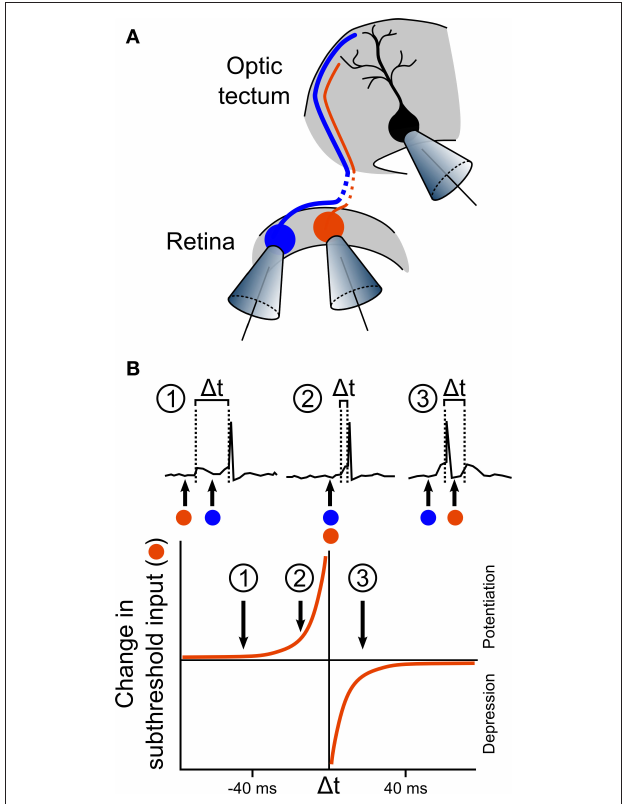
Figure 2 | First in vivo observation of STDP in the optic tectum. (A) The first in vivo demonstration of STDP was performed by Zhang et al. (1998) in an elegant experiment, illustrated here. Activity from a single tectal neuron was recorded using whole-cell perforated patch, while two different RGCs that form synaptic connections onto the tectal neuron were loose-patched, allowing stimulation for induction of LTP or LTD. In some of the recordings, one RGC produced suprathreshold responses (illustrated by the blue cell), whilst the other produced only subthreshold responses (illustrated by the orange cell). (B) Analysis of the effects of the timing of the inputs showed that the effect of stimulation on the subthreshold input depended on the timing of its excitatory postsynaptic potentials (EPSPs) relative to the tectal spike that was triggered by the suprathreshold input. If the subthreshold EPSP preceded the tectal spike by more than 20 ms, the input was relatively unaffected (inset 1). However, if the subthreshold EPSP occurred within the 20 ms before the suprathreshold EPSP, and therefore just before the tectal spike, the input was strongly potentiated (inset 2). In stark contrast, if the subthreshold EPSP occurred during the 20 ms immediately following the tectal cell spike, this input was depressed (inset 3). Examination of the effects of a range of timing differences led to an estimated curve for the STDP rule in retinotectal